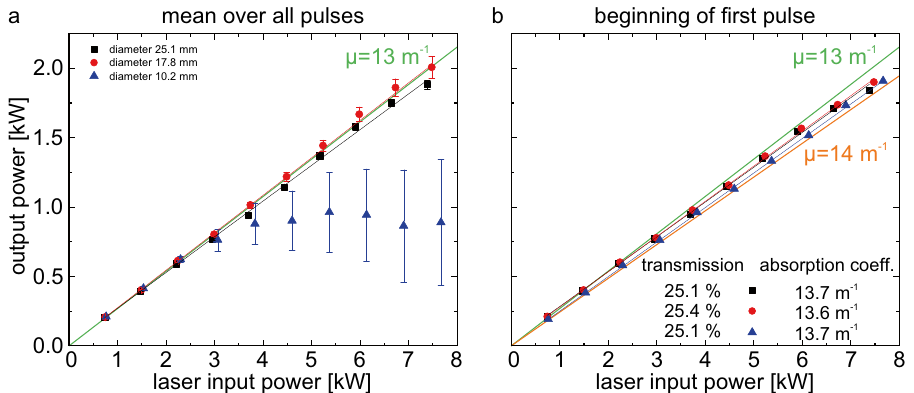
Figure 5. Output power as power in the bucket (aperture diameter 30 mm) as function of the input power. In ( a ), the mean value of the complete laser-on-time of three pulse trains (each 5 pulses of 0.1 s duration) is shown. Only for the larger spot diameters a linear behaviour is observed. In ( b ), only the power in the bucket at the beginning of the first pulse is plotted. Here, the power in the bucket is still a linear function with the input power for the smallest spot diameter. The green and orange lines are guide to the eyes for two different absorption coefficients.